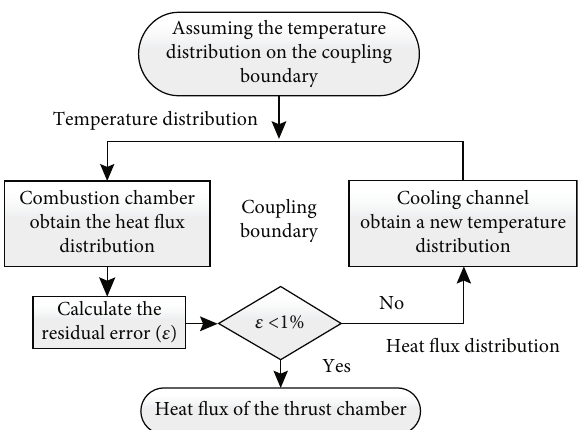
Figure 1: Schematic of the iteration